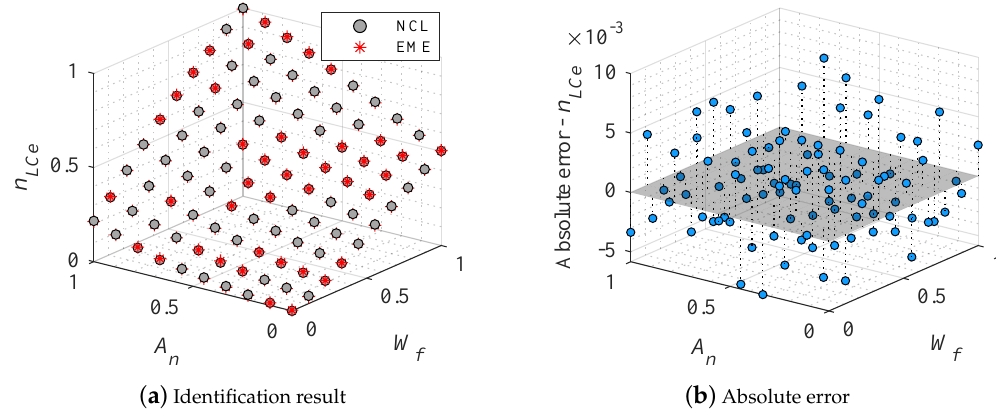
Figure 10. The identification result and absolute error of the EM